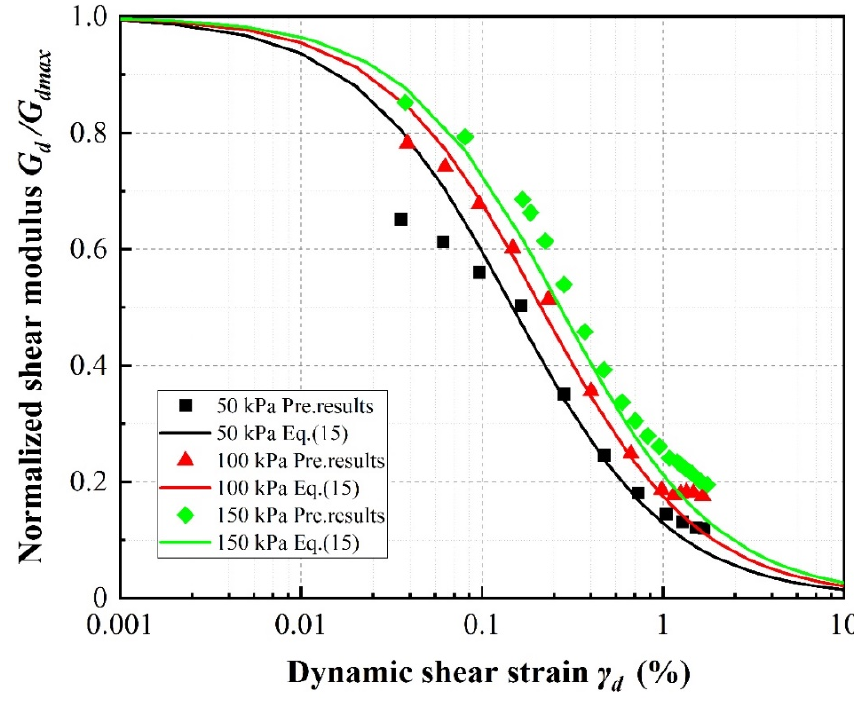
Figure 23. Normalized shear modulus versus shear strain amplitude for 20% rubber content SRP2 according to applied confining pressure.